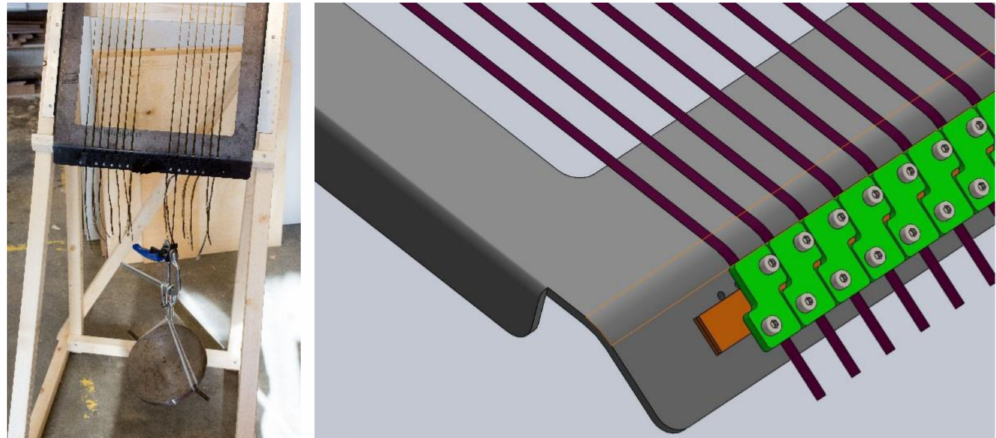
Figure 3. Fiber-tensioning frame. Left image: tensioning with a static load of 150 N per fiber. Right image: schematics of fixing the tensioned fiber. Tensioned fibers (brown) are fixed between two rubber ribbons (orange) by screwing a steel plate (green) tightly against the frame.